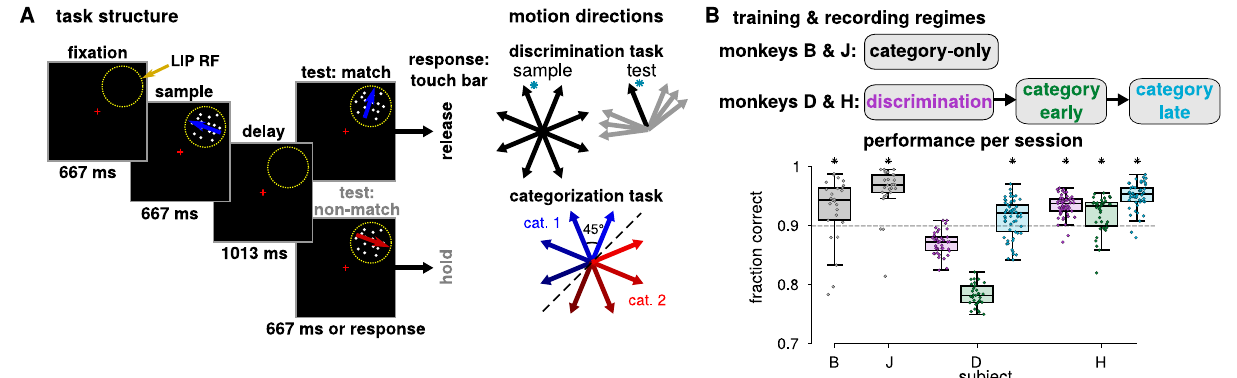
Fig. 1 | Motion direction discrimination and categorization tasks. A In both tasks, the animal fi xated and viewed a motion direction stimulus (sample). Fol- lowingadelayperiod,asecondstimulus(test)waspresented.Themonkeysignaled if the sample and test stimuli matched by releasing a touch bar, otherwise the monkey was required to hold the touch bar. In the discrimination task, the sample and test stimuli matched only if the directions were exactly the same. In the cate- gorization task, the stimuli matched if they belonged to the same category: the motion directions were split into two equally sized categories with a 45° – 225° boundary(redandbluedirections;theboundarywasconstantforallsessions).The motionstimuliwereplacedinsidetheLIPcell ’ sresponse fi eld(yellowcircle)during recording. B (Top)Trainingandrecordingregimesforthefourmonkeys.(Bottom)